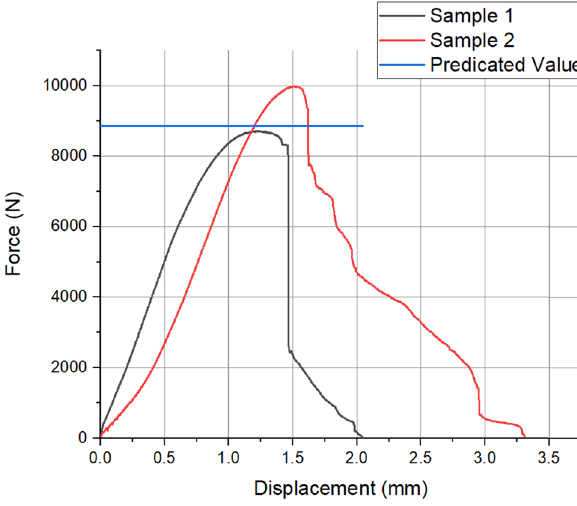
Figure 16: Con fi rmation test.